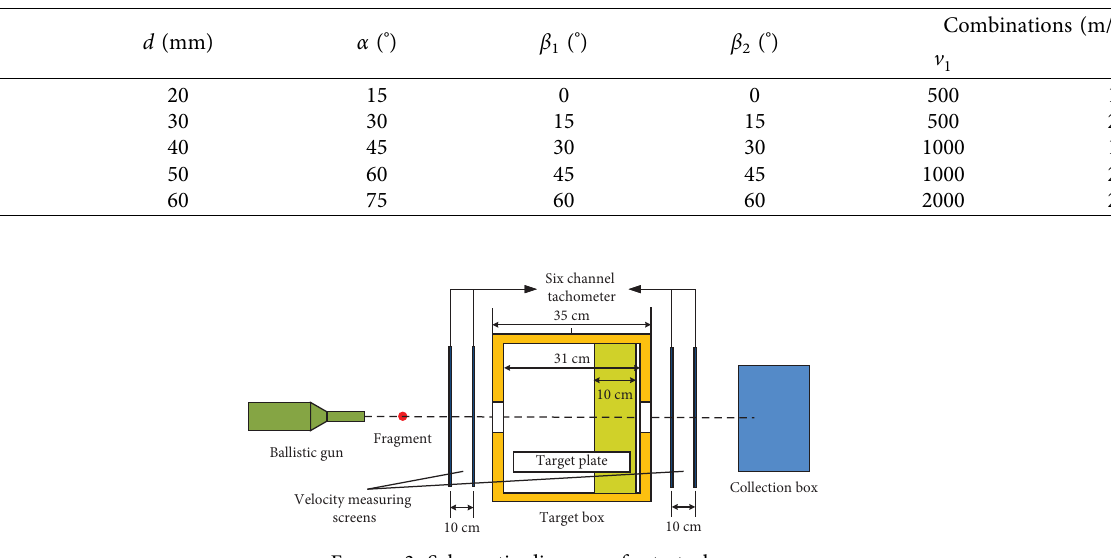
Figure 2: Modeling of double fragment penetration in diferent planes. Table 4: Orthogonal optimization table of 5 factors and 5 levels for diferent surface fragment penetration.